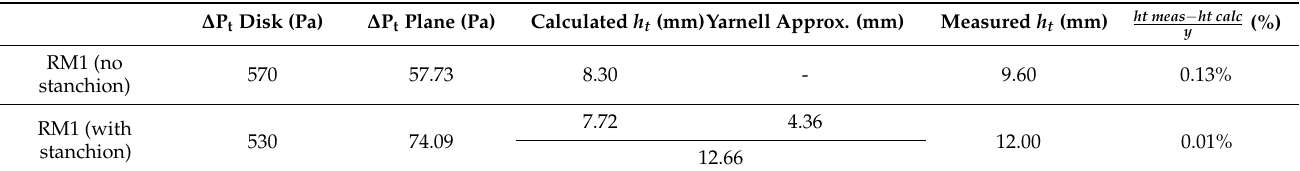
Figure 13. Pressure measurements over the disk and planes upstream and downstream of the RM1 turbine and retaining structure. Table 4. Comparison of measured and predicted backwater